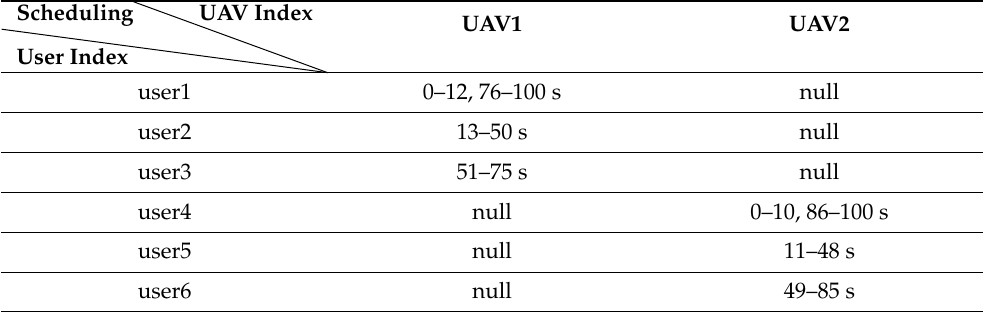
Table 3. Communication scheduling for two UAVs.